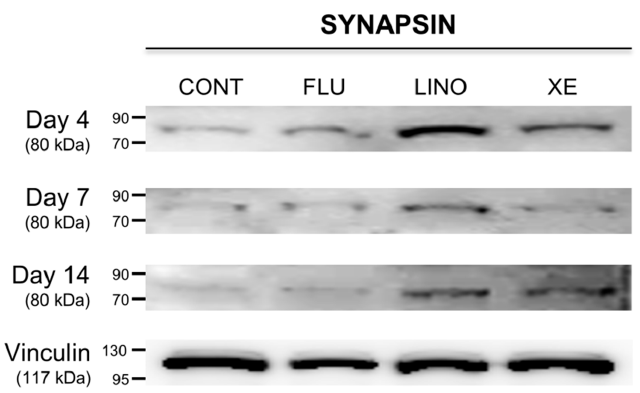
Figure 8. Regulation of synaptic vesicle-related protein, synapsin, by K V 7.3 channel in MG-63 cells. Western blot analysis showed that K V 7.3 blockade by linopirdine (30 µ M) or XE991 (10 µ M) increased synapsin expression during osteoblast differentiation. However, K V 7 activation by flupirtine (30 µ M)